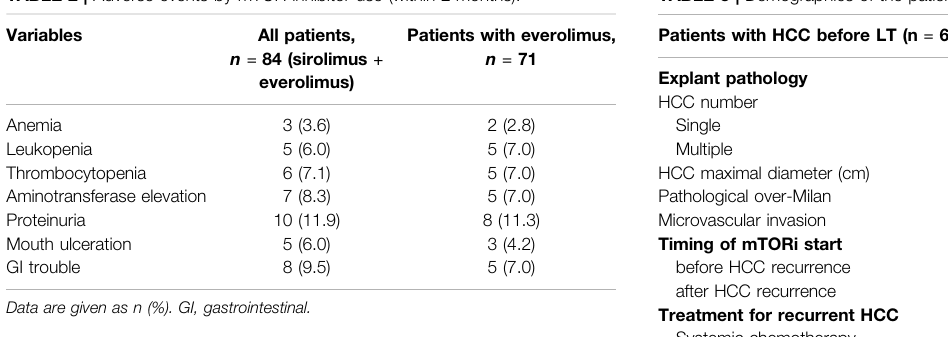
(9.5%) patients with TAC withdrawal or minimization. The rejection rates between TAC withdrawn and TAC minimizing